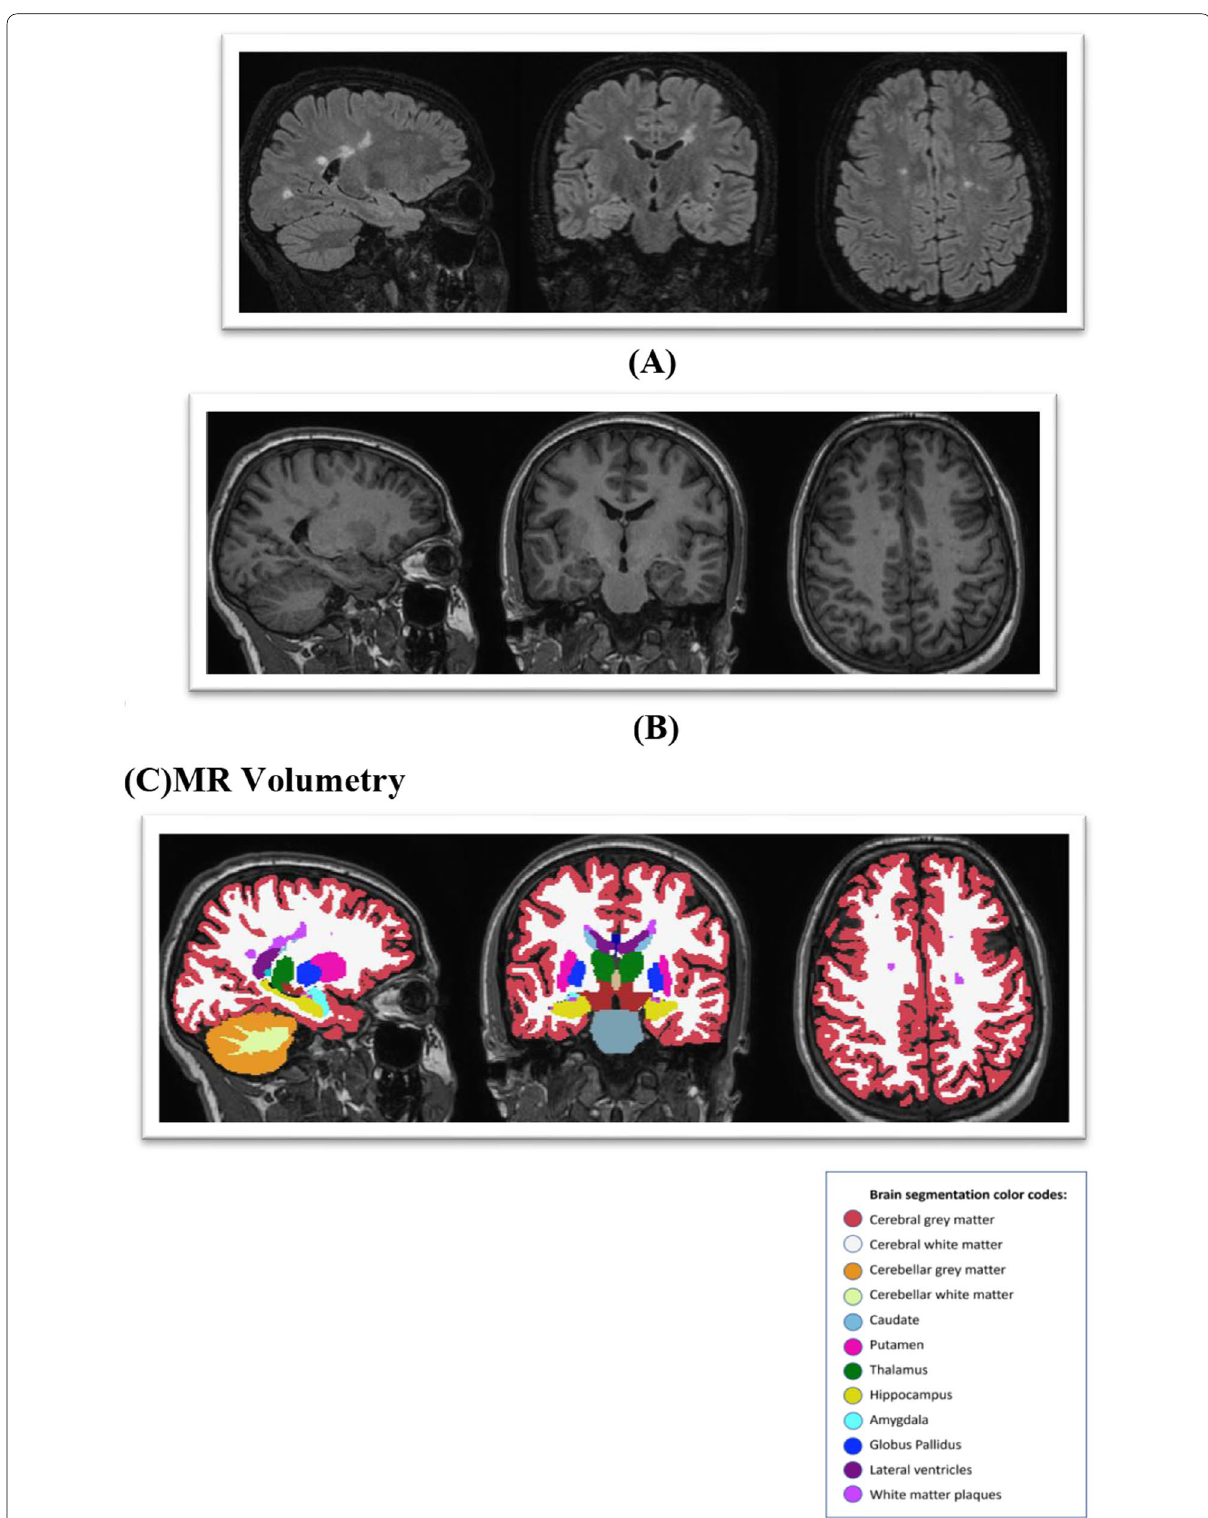
Fig. 11 27 year old male diagnosed with MS 5 years ago with EDSS (3) with features of cognitive impairment: ( A ) 3D FLAIR images showing multiple foci and patchy areas of high signal intensity implicating the peri ventricular and juxta cortical white matter. ( B ) 3D T1 images showing multiple foci and patchy areas of slightly low signal intensity implicating the peri ventricular and juxta cortical white matter. ( C ) MRI